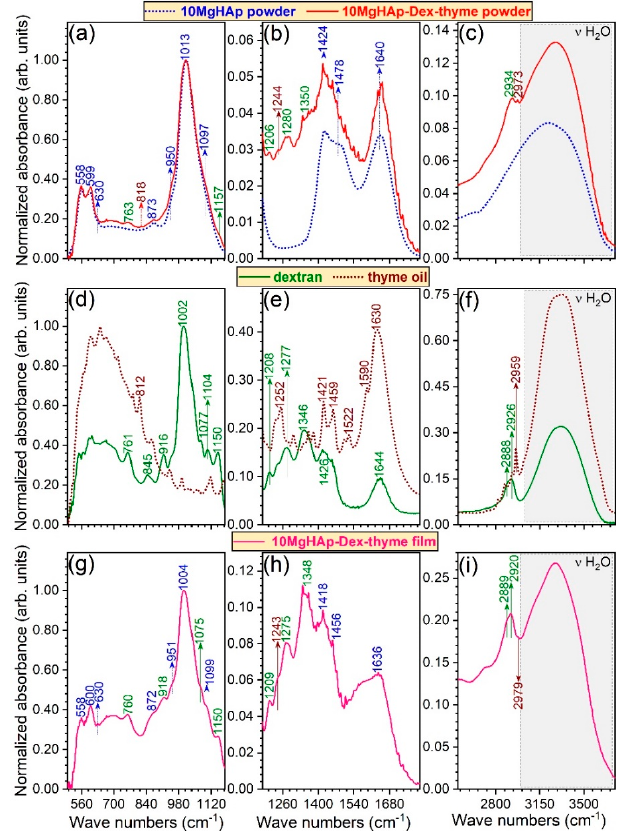
Figure 10. Comparative FTIR-ATR spectra of the ( a – c ) 10MgHAp (dotted line) and 10MgHAp-Dex-thyme powders (solid line); ( d – f ) dextran and thyme essential oil raw materials; and ( g – i ) 10MgHAp-Dex-thyme coating, zoomed over three relevant ( a , d , g ) fingerprint and ( b , c , e , f , h , i ) functional groups regions: ( a , d , g ) 500–1180 cm –1 ; ( b , e , h ) 1180–1800 cm –1 ; and ( c , f , i ) 2500–3750 cm –1 .